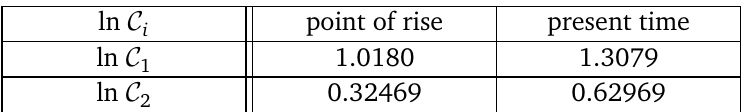
Table 6: Log of complexity values at point of rise and present time. In this case we do not observe any saturation as such, hence we compute the slope between the point of rise and the present time. Point of rise for both factor corresponding to the present time is a =